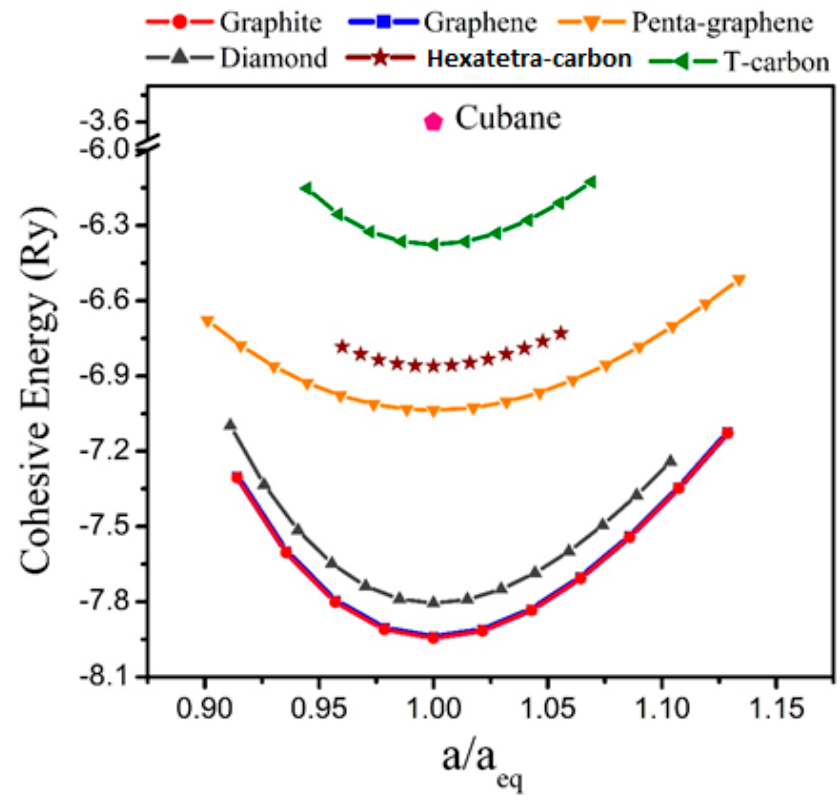
Figure 2. Cohesive energy of different carbon allotropes.